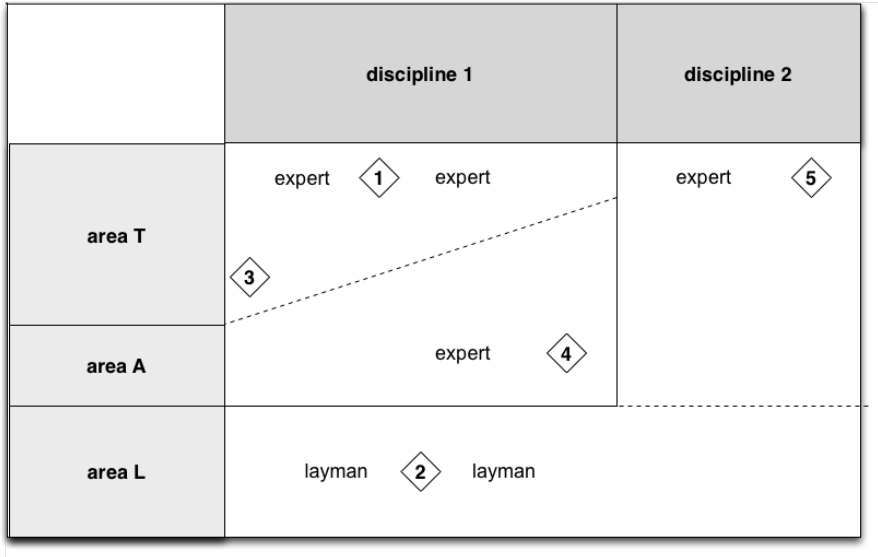
Fig.3: Vertical structuring (translated from Roelcke